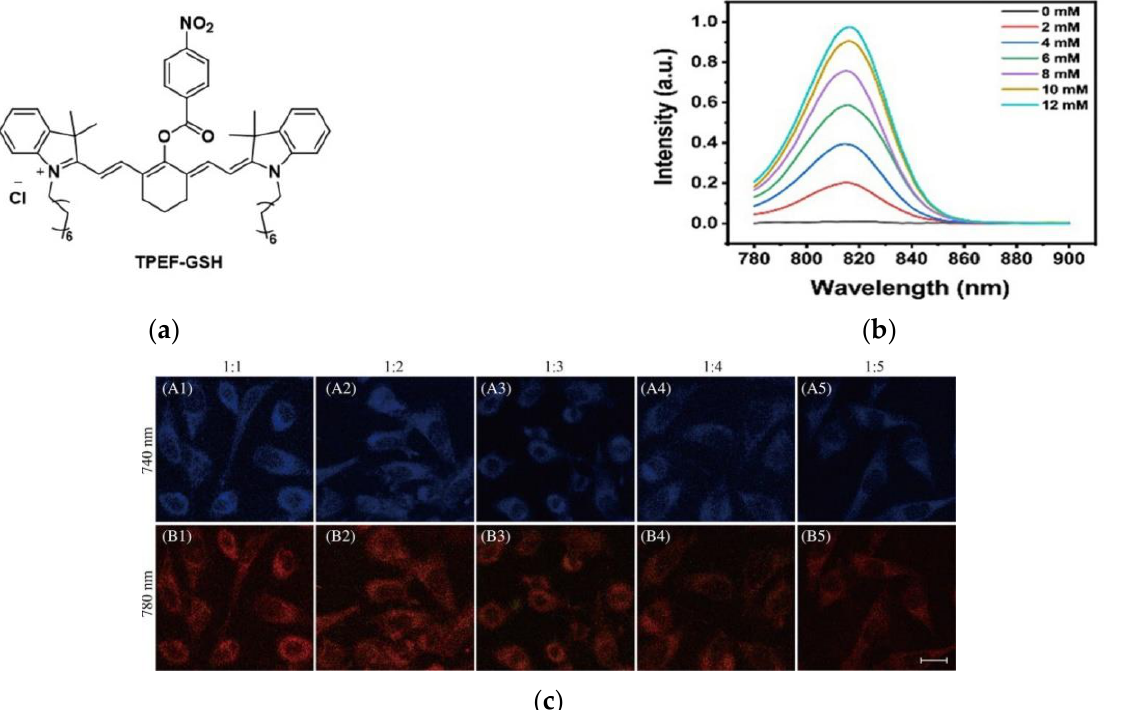
Figure 22. ( a ) Structure of TPEF-GSH; ( b ) The GSH concentration-dependent fluorescence spectra; ( c ) Fluorescence imaging of HeLa cells under different GSH concentrations (GSH:PBS = 1:1 – 1:5). Reproduced with permission from [93]. Copyright 2022 Wiley-VCH GmbH.